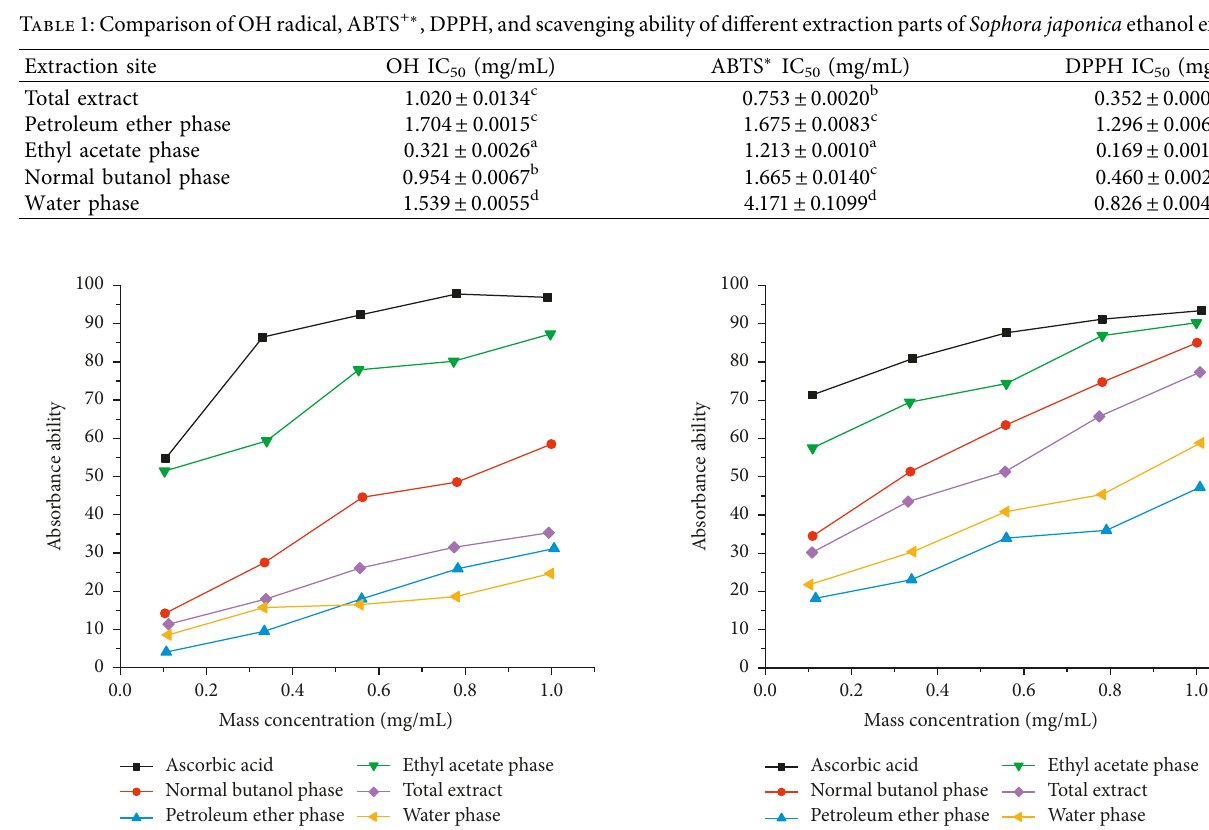
Figure 6: Different extraction parts of Sophora japonica ethanol extract on DPPH · scavenging ability ( n �